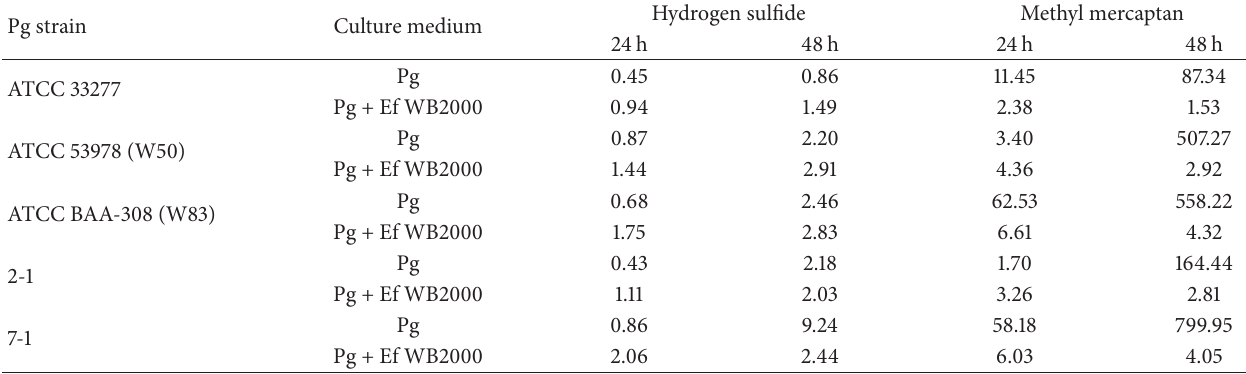
Table 2: The hydrogen sulfide and methyl mercaptan concentrations in spent culture medium (ng/mL). Pg strain